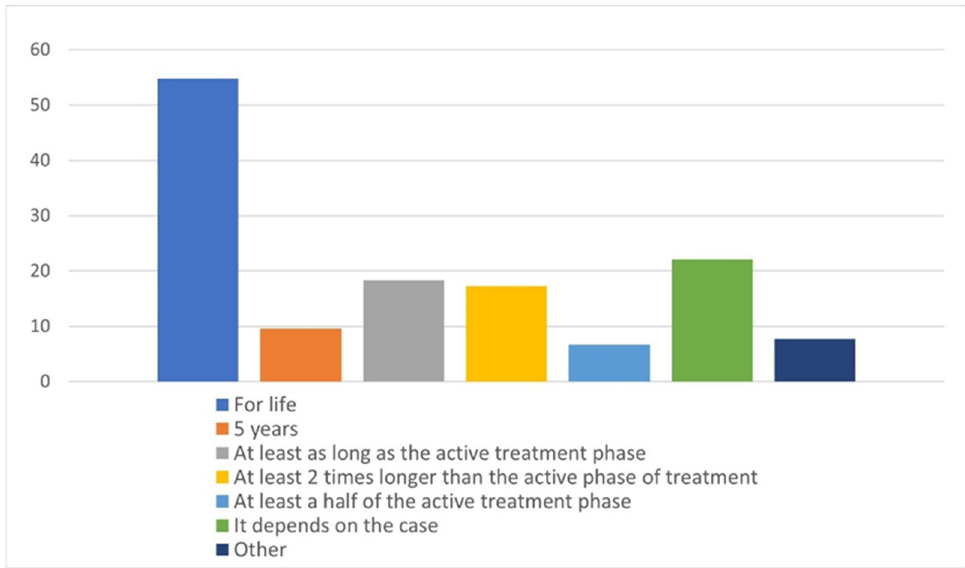
Figure 3. The duration of follow-up declared by the respondents.